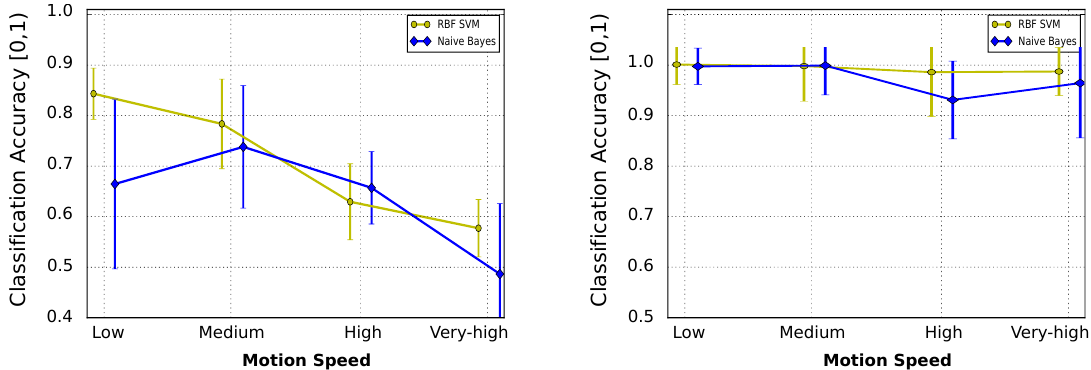
Figure 6. Average classification accuracy for different motion speeds using two classifiers (Naive Bayes and RBF SVM (Radial Basis Function for Supported Vector Machine)): ( Left ) classification accuracy when training the classifiers with static data samples; and ( Right ) results when the classifiers have been trained with data collected in